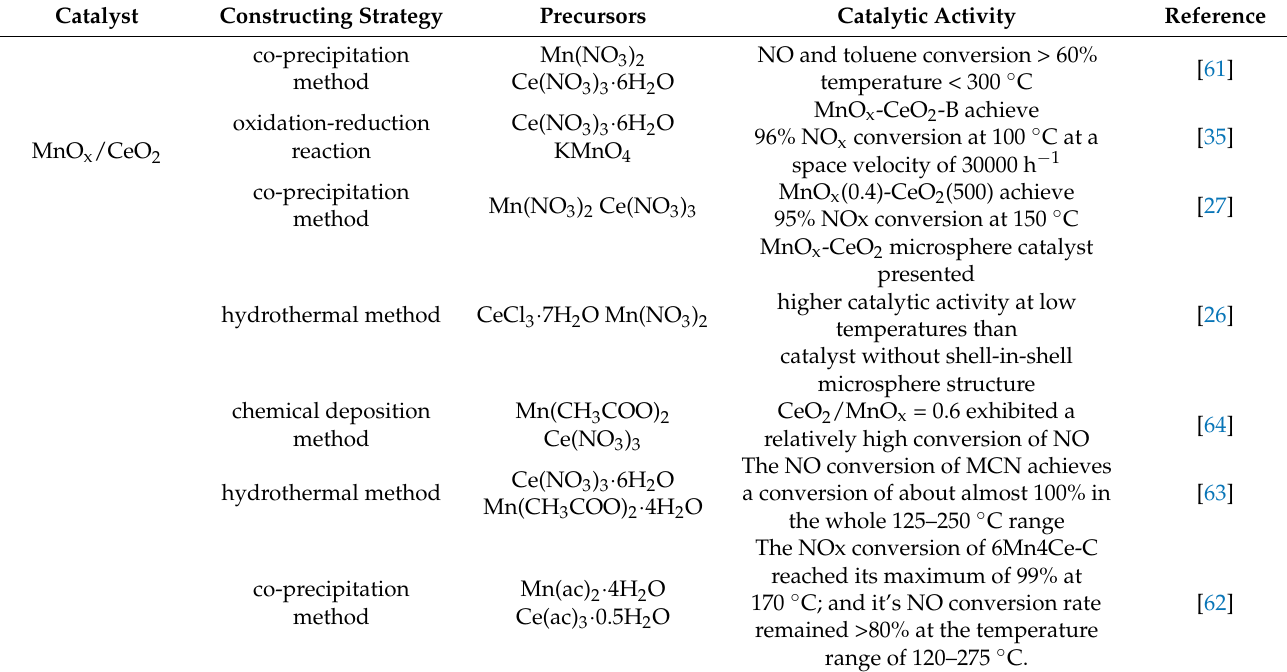
Table 1. The preparation of MnO x /CeO 2 binary